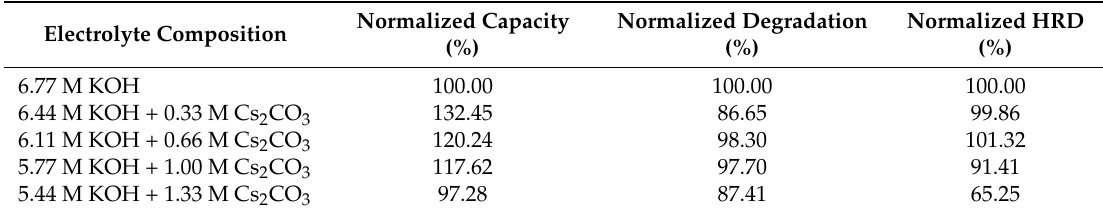
Table 2. Normalized discharge capacities, degradations, and high-rate dischargeabilities (HRDs) of AR3 cycled in five different electrolytes.